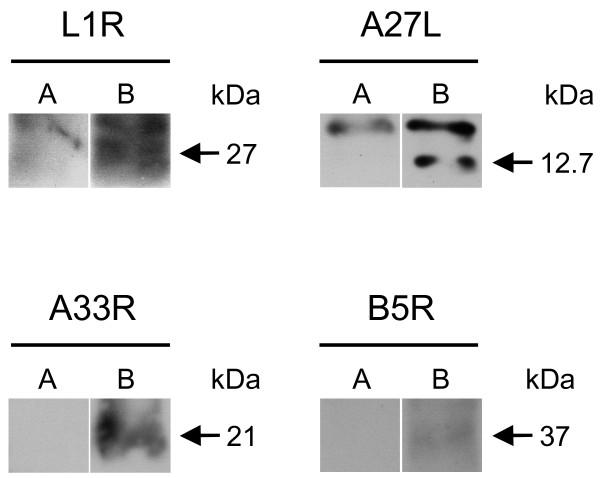
Immunoprecipitation/Western blotting. To verify the recognition of the FP-expressed proteins also by VV-specific hyperimmune mouse sera, immunoprecipitation was performed, followed by Western blotting. After infection with FPL1R, FPA27L, FPA33R or FPB5R, the specific proteins were immunoprecipitated by the hyperimmune sera (lanes B). No specific bands were seen in cells infected with FPwt (lanes A).